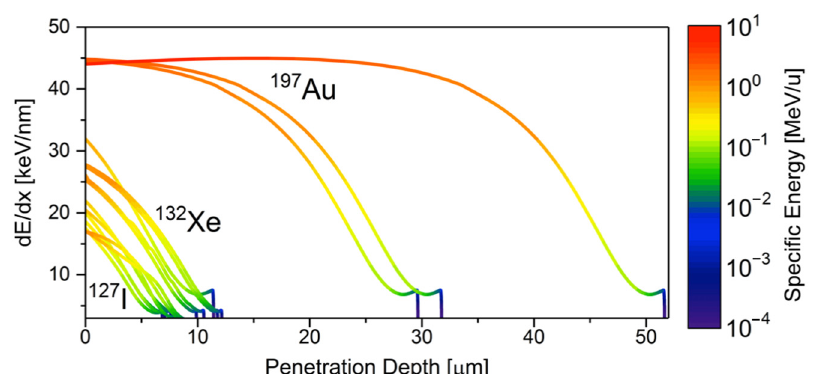
Figure 2. Energy loss profiles as a function of penetration depth determined with SRIM 2013 [57] for the ions used in the majority of studies [32–56] on SHI irradiated CeO 2 , assuming 100% theoretical density. The color scale corresponds to the specific energy of ions and indicates the change in energy as ions penetrate into the material. The three ion species illustrate the range of masses and species used in these studies.